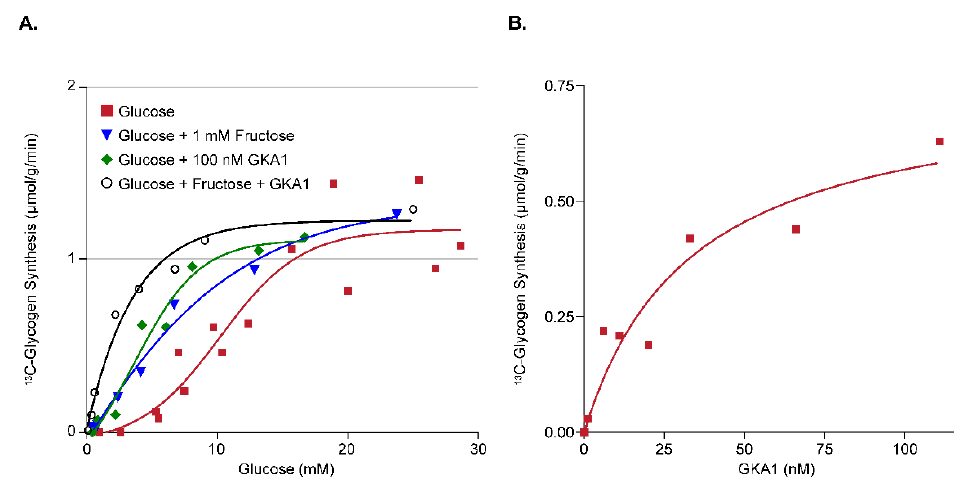
Figure 5. ( A ) The relationship between perfusate [1- 13 C] glucose concentration and 13 C-glycogen synthesis for untreated livers (red), and livers perfused with 1 mM of fructose (blue), 100 nM of GKA1 (green), or 1 mM of fructose + 100 nM of GKA1 (black). ( B ) The titration of GKA1 at a perfusate [1- 13 C] glucose concentration of 5 mM.